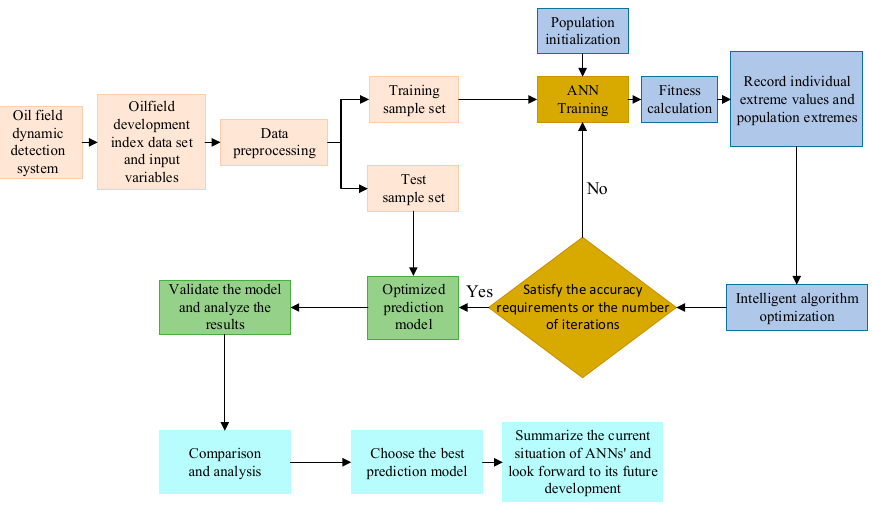
Figure 4. Research block diagram of oilfield development index prediction.